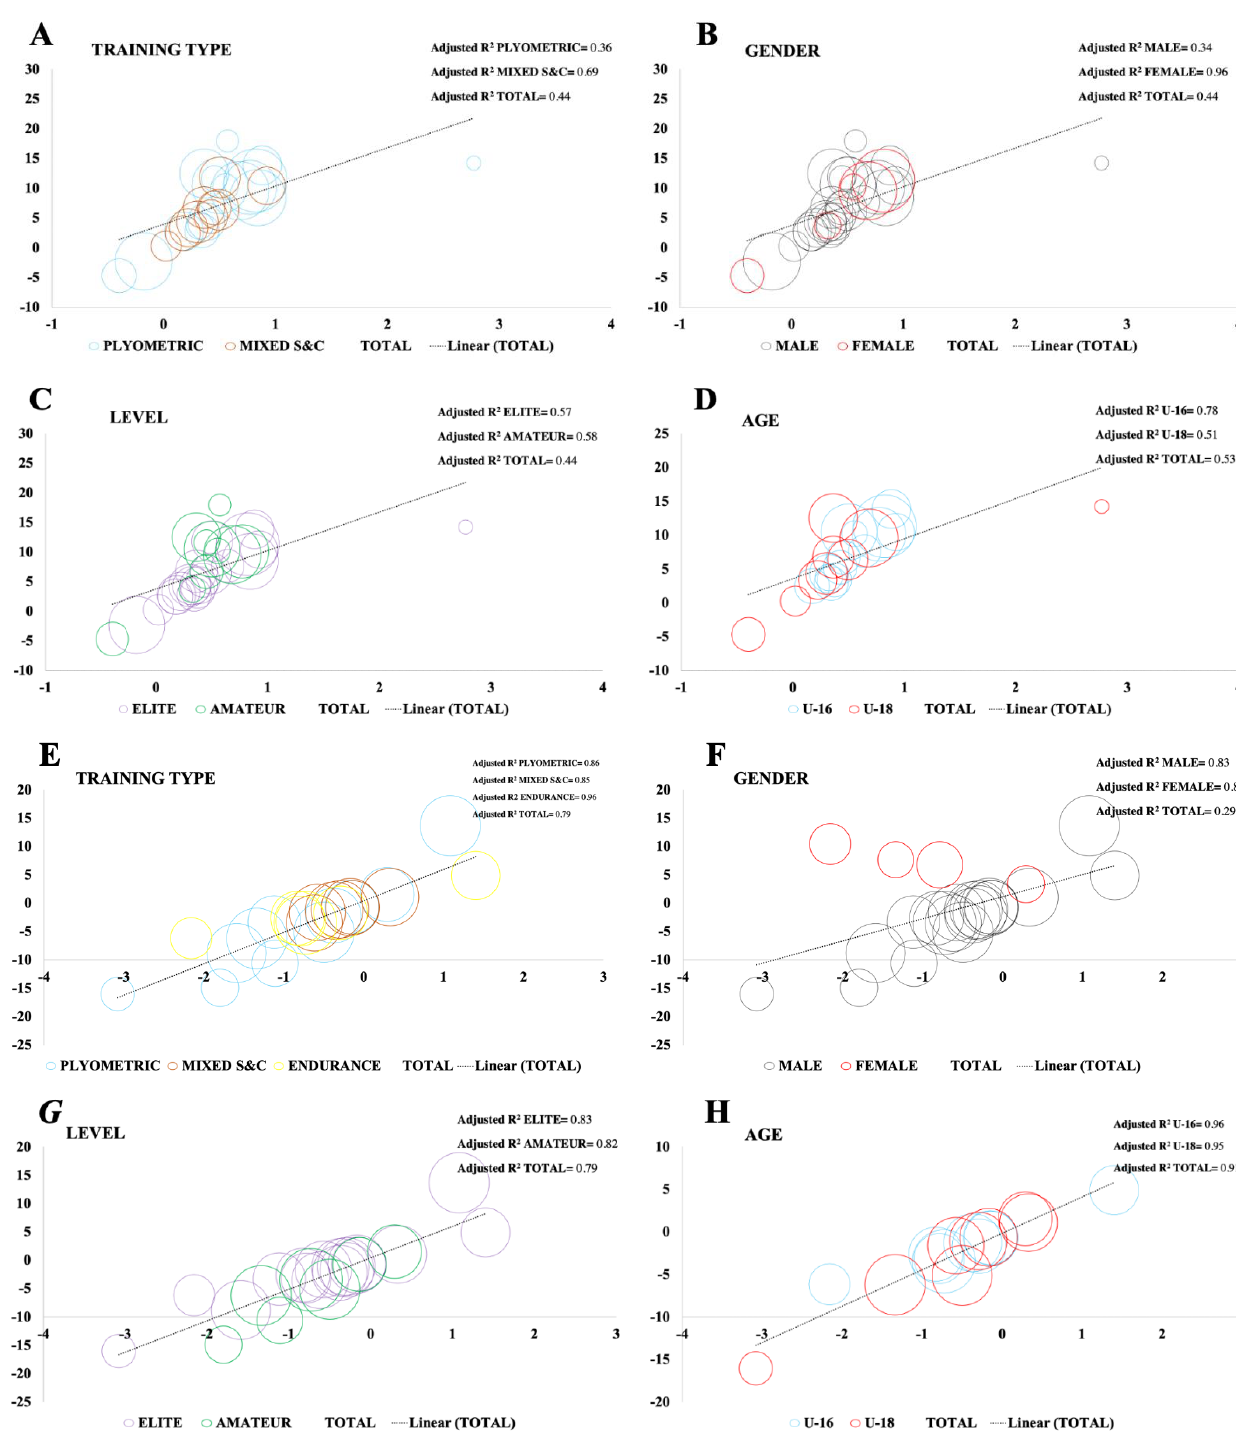
Figure 8. Meta regression models for neuromuscular power vertical ( A – D ) considering sub-groups: